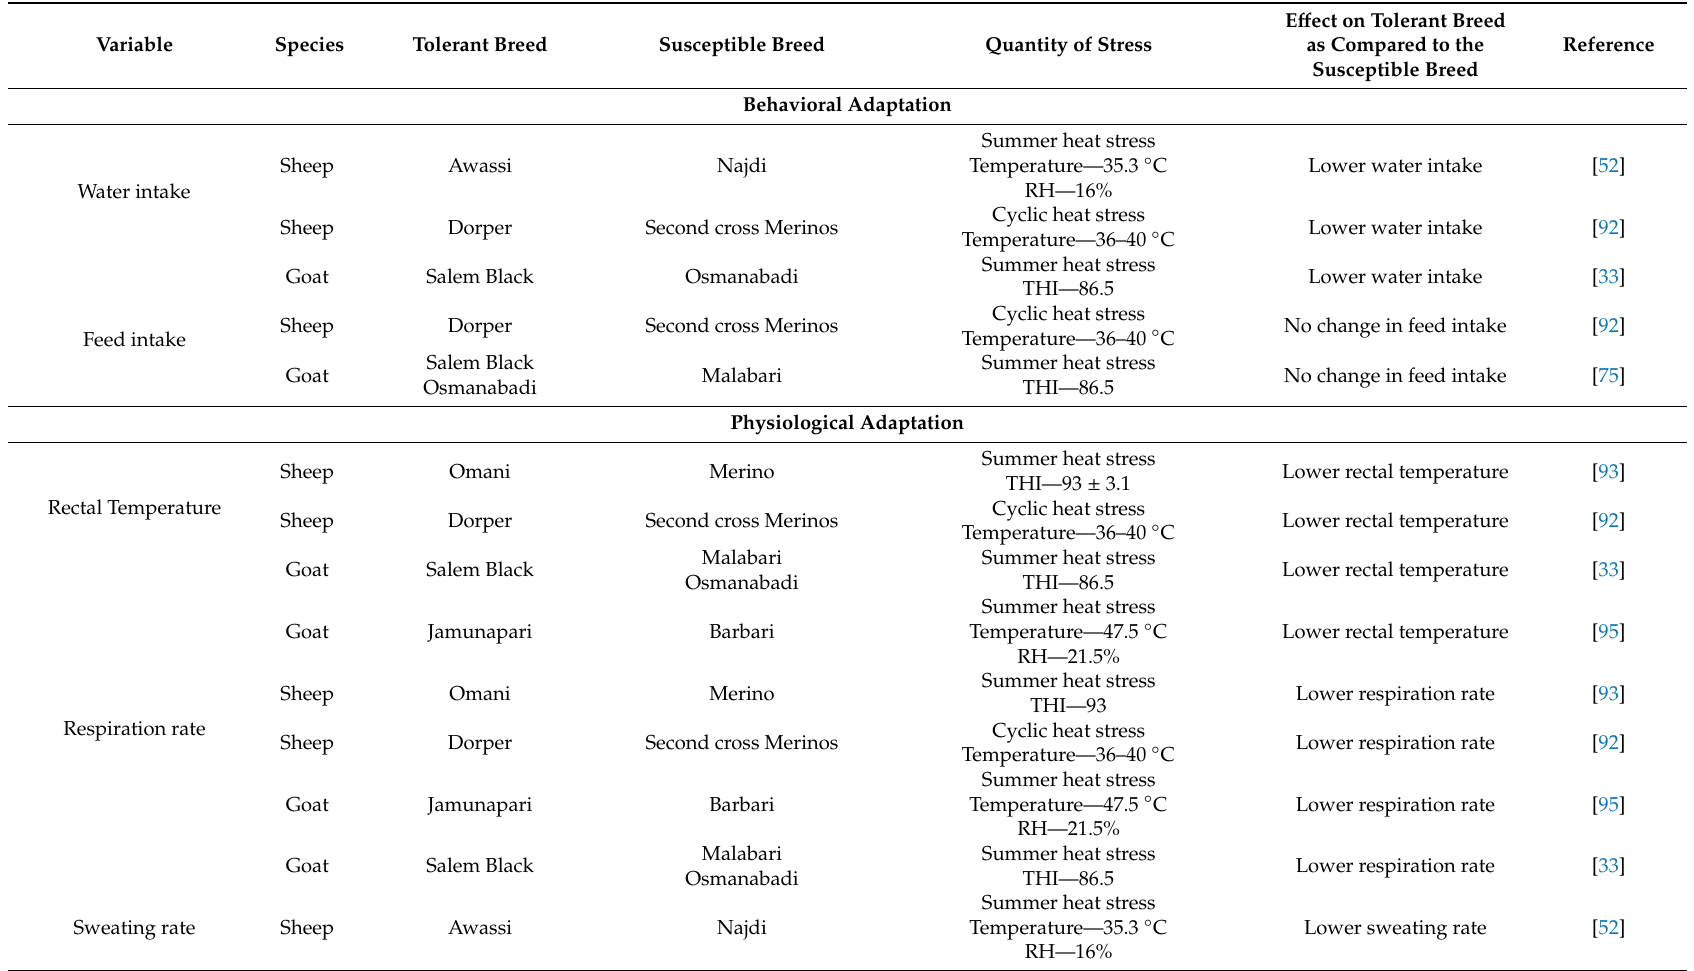
Table 1. Biological markers for breed di ff erences in small ruminants for thermotolerance